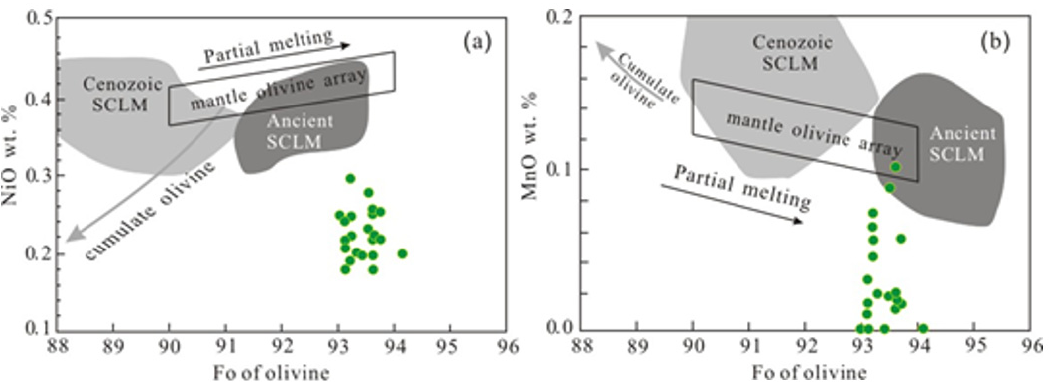
Figure 6. Compositional variations of olivine. ( a ) NiO vs. Fo. ( b ) MnO vs. Fo. The mantle olivine array is based on Hattori et al. [42]. Partial melting trend is from Ozawa [43]. Trend of cumulate olivine is from Ozawa [43] and Nakamura [44]. Fields of Ancient and Cenozoic subcontinental lithospheric mantle (SCLM) are from Xie et al. [2] and references therein.